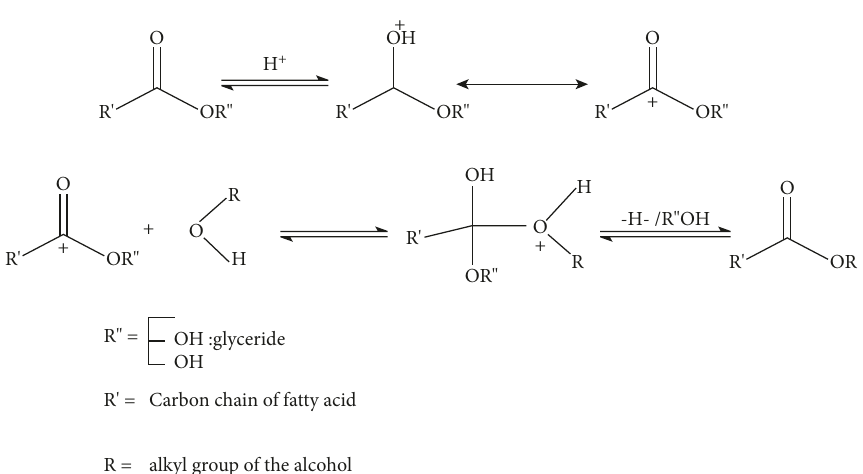
Figure 5: The mechanism of acid-catalyzed transesterification